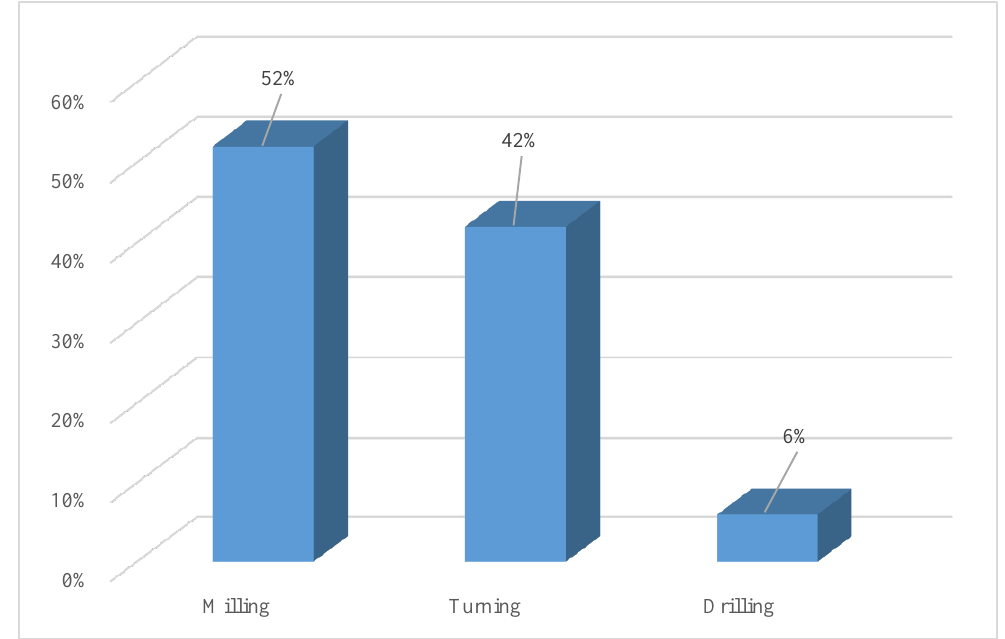
Figure 4. The frequency studying of the cutting operations of the aluminum alloys 2005–2019 period.